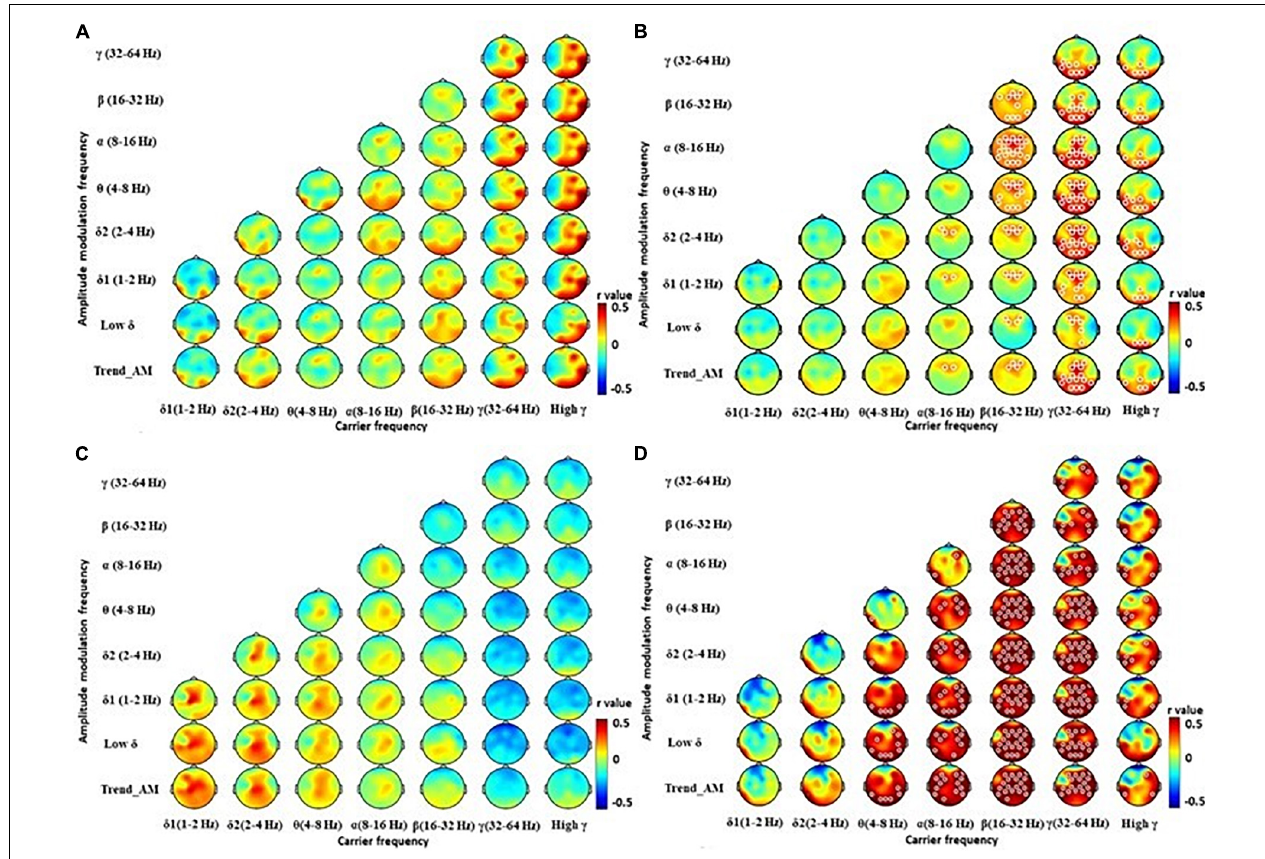
FIGURE 4 | Correlation between powers of Holo-Hilbert Spectrum Analysis (HHSA) and Hamilton Depression Rating Scale (HAM-D). The contrasted HHSA for correlation between HAM-D and (A) healthy controls, (B) patients with Parkinson’s disease (PD), (C) PD patients at early stage (EPD), (D) PD patients at late stage (LPD). The white circles indicate that contrast on those EEG channels is statistically significant ( P < 0.05, cluster permutation test, two-tailed). Color notations depict the r value of correlations (shown up to 0.05 for easier visualization purposes).